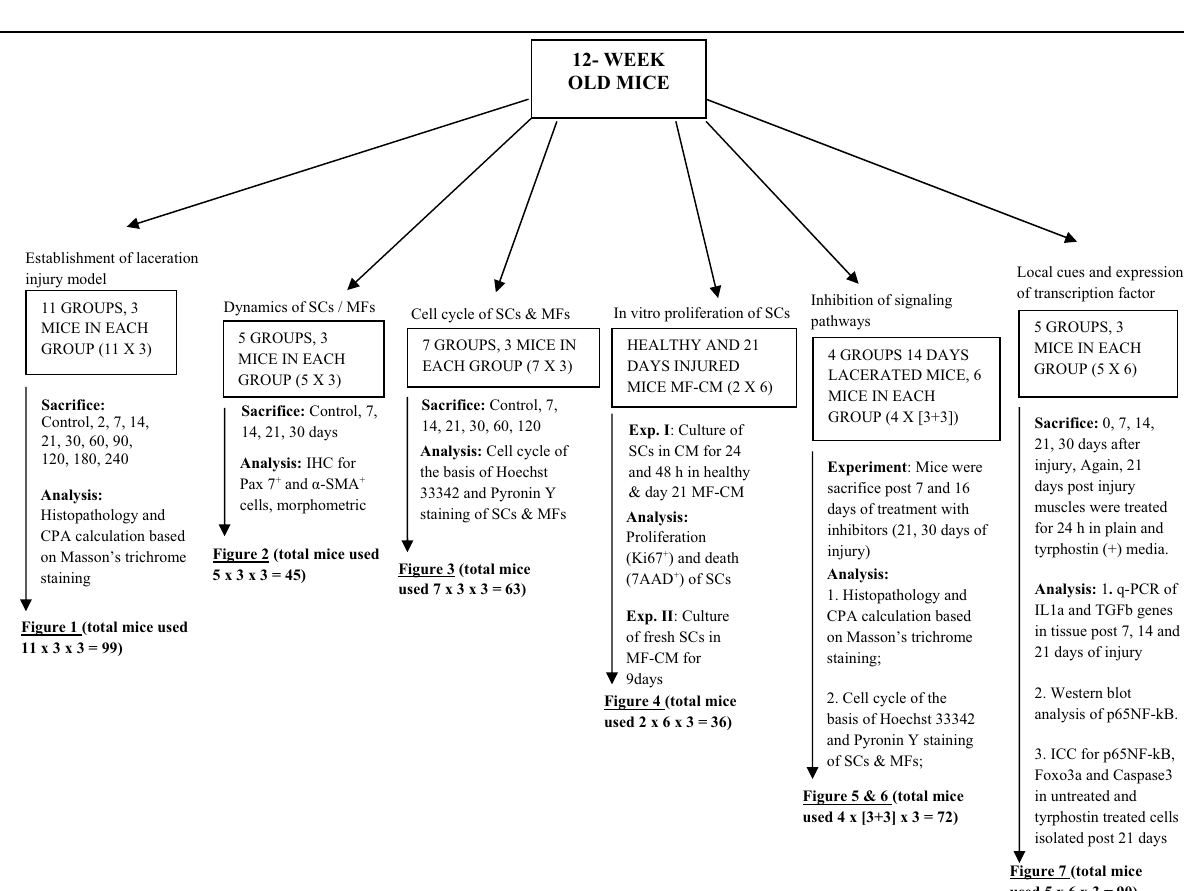
Table 1. Details of plan of the experiments and mice utilized for this